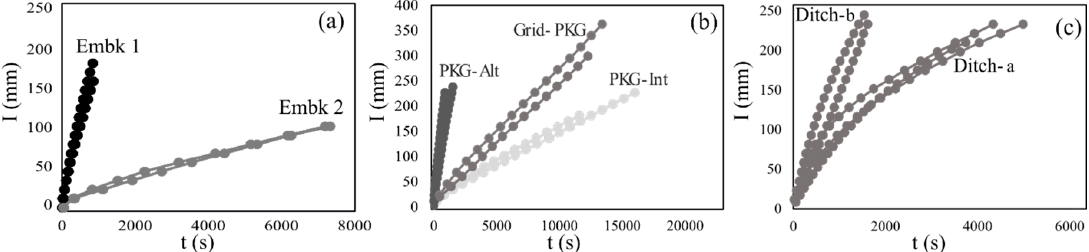
Figure 3. Examples of Beerkan infiltration curves of the studied soils: ( a ) Embk 1 and Embk 2; ( b ) PKG-Int, PKG-Alt, and Grid-PKG; ( c ) Ditch.